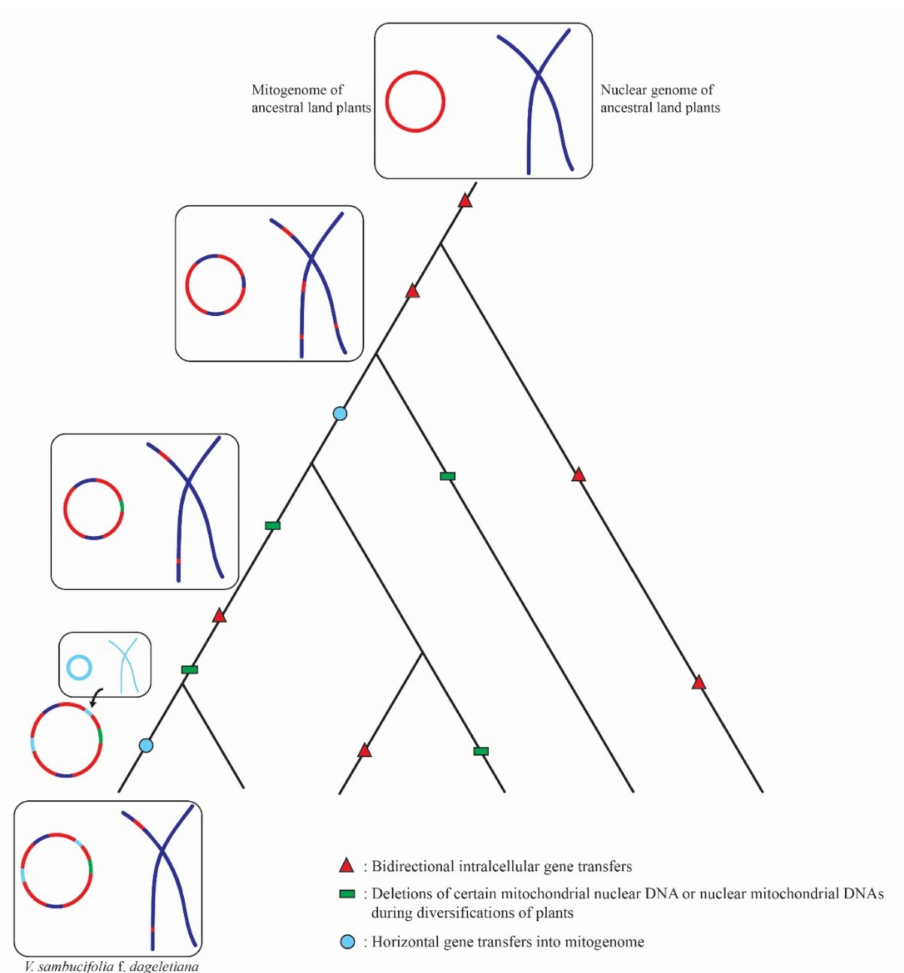
Figure 6. Model of the proposed origins of unidentified mitogenome sequences found in Valeriana sambucifolia f. dageletiana